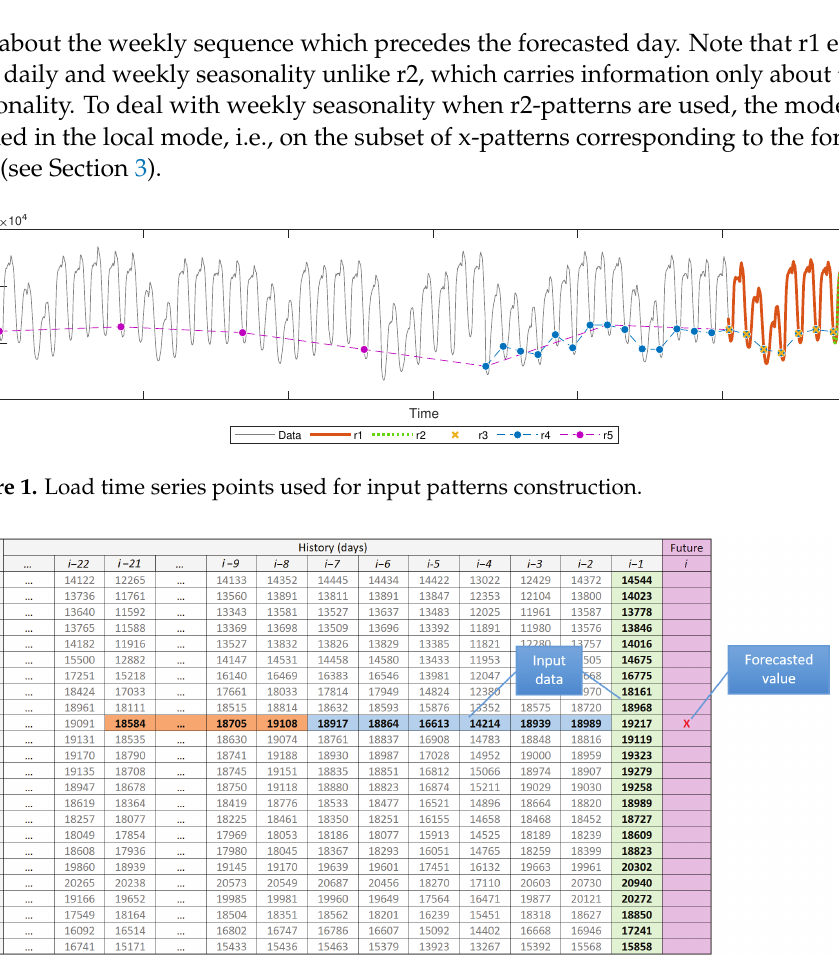
Figure 2. Cross-patterns: r6 (green + blue) and r7 (green + orange + blue). Pattern r3 introduces information on the demand in the previous seven days at the same hour as the forecasted one. It expresses only weekly seasonality. Information about the daily seasonality is not included, so the local mode of training, i.e., training on the selected r3-patterns corresponding to the forecasting task (see Section 3), can help with dealing with daily seasonality. Similar information as in r3 is contained in pattern r4 but from a longer 3-week period. Pattern r5 shows neither daily nor weekly seasonality. It carries information about the demand at the same hours as forecasted in previous days of the same type as the forecasted